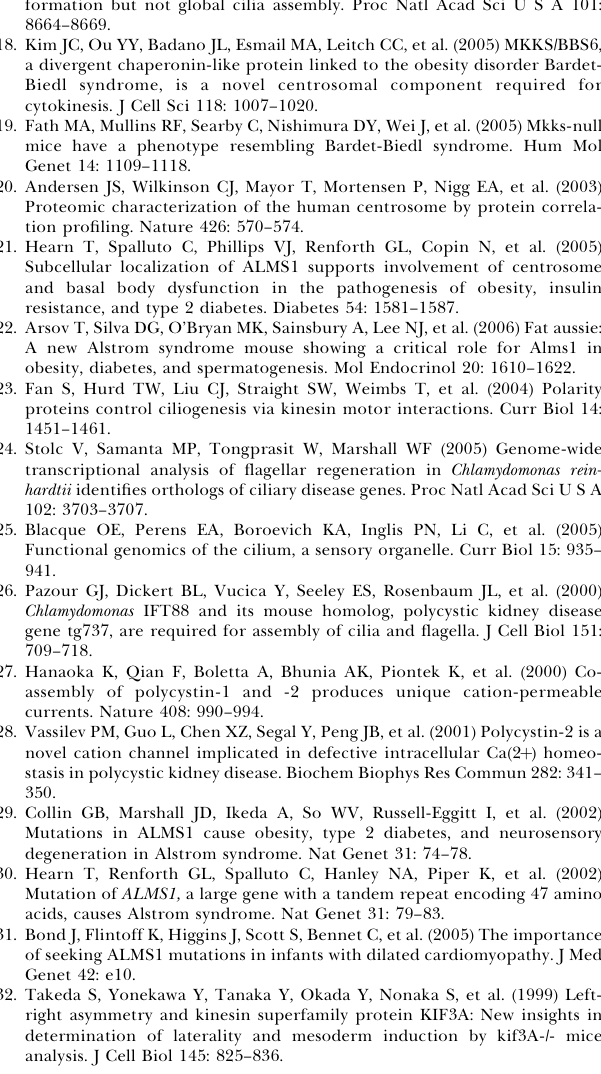
Figure S2. Serum Analytes in Alms1 L2131X/L2131X Mice and Controls Plasma glucose, triglyceride, insulin, leptin, total cholesterol, and HDL cholesterol measurements in 60- to 80-d-old and 140- to 170-d- old Alms1 L2131X/L2131X , Alms1 þ /L2131X , and Alms1 þ / þ mice. Arrow, diabetic mutant male. Figure S3. LossofCiliaintheKidneyCortexofAged Alms1 L2131X/L2131X Mice Cilia are lost in the cortex tubules (A) but not in the medulla tubules (B) in an age-dependent manner. Cilia were stained with an anti- acetylated tubulin antibody. Table S1. Gene Expression Changes after Knockdown of Alms1 Gene expression levels of 98 genes with the most dramatic changes